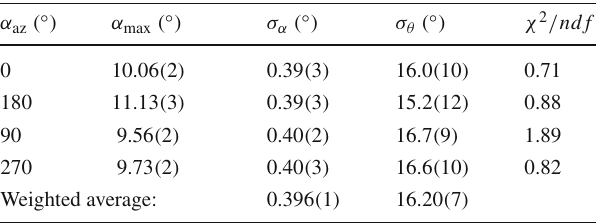
Table 2 Measured magnetic reflection curves at different azimuthal directions α az of the plate angle (Fig. 8). The table shows the reflection angle ˆ α = α max and the width σ α (in terms of plate angle) of the reflec- tioncurvethatwasdeterminedbythefit.Theangularspread σ θ (interms of pitch angle) has been computed from the adiabatic transformation (15) with the known reflection